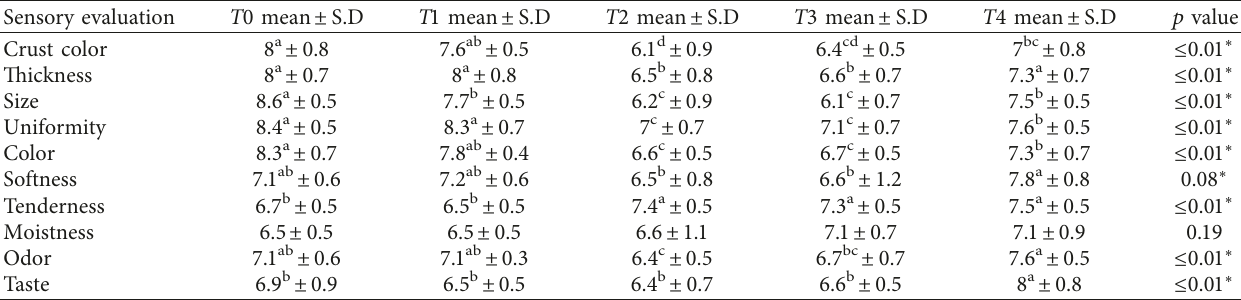
Table 7: Sensory evaluation of various gluten-free cupcakes and control (baseline).